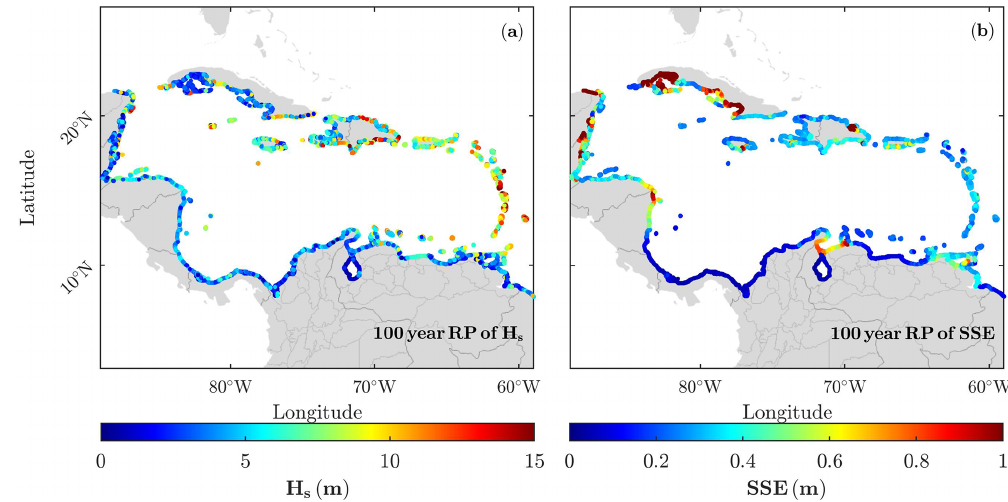
Figure 7. Return levels of the variables H s (a) and SSE (b) for the 100-year return